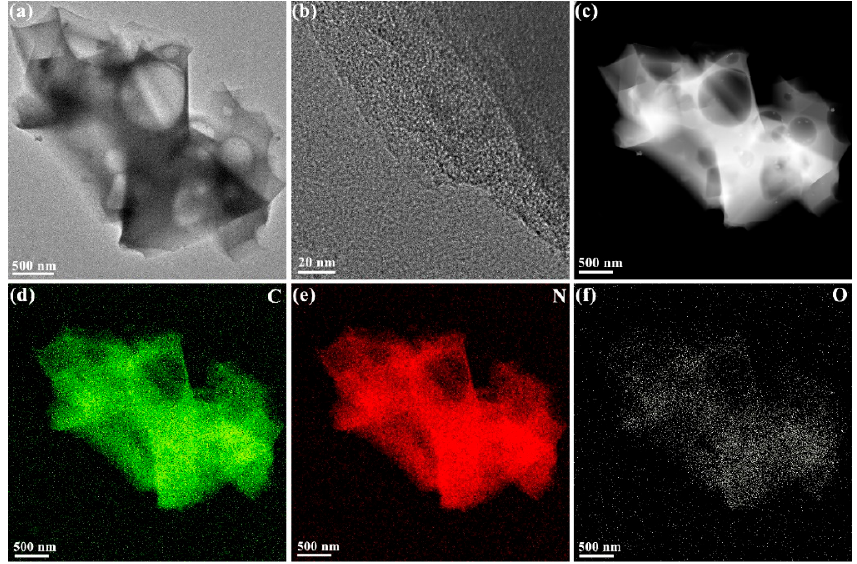
Figure 2. ( a and b ) TEM images and ( c – f ) EDX mapping of MGCs-2.